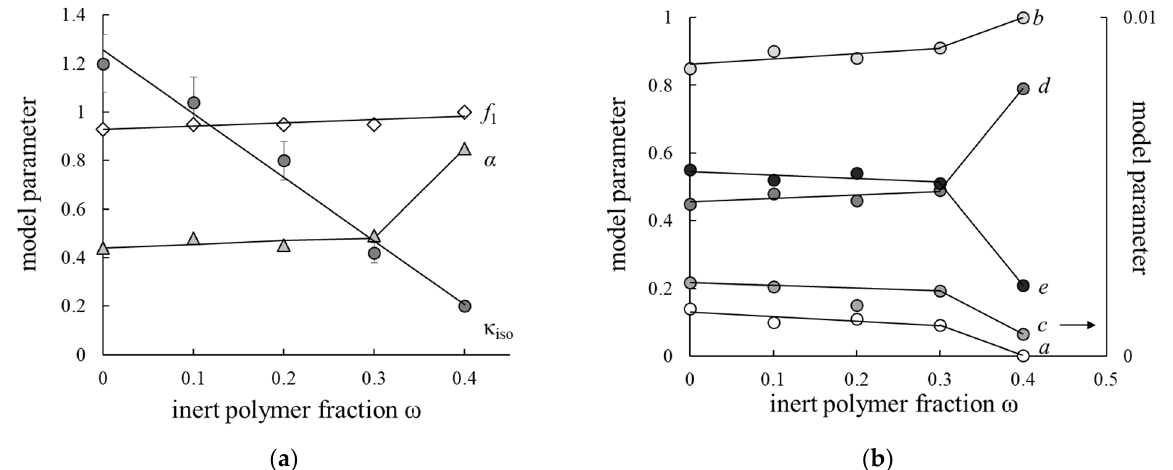
Figure 4. Values of transport-structural ( a ) and geometric ( b ) parameters of ETWM as dependencies on F-26 content in membranes. f 1 is volume fractions of gel phase; α is the structural parameter reflecting the spatial orientation of conducting phases inside the material; a , b , c are fractions of current passing through mixed, gel and solution channels ( a + b + c =1); d , e are fractions of solution and gel in mixed channel a ( d + e = 1).